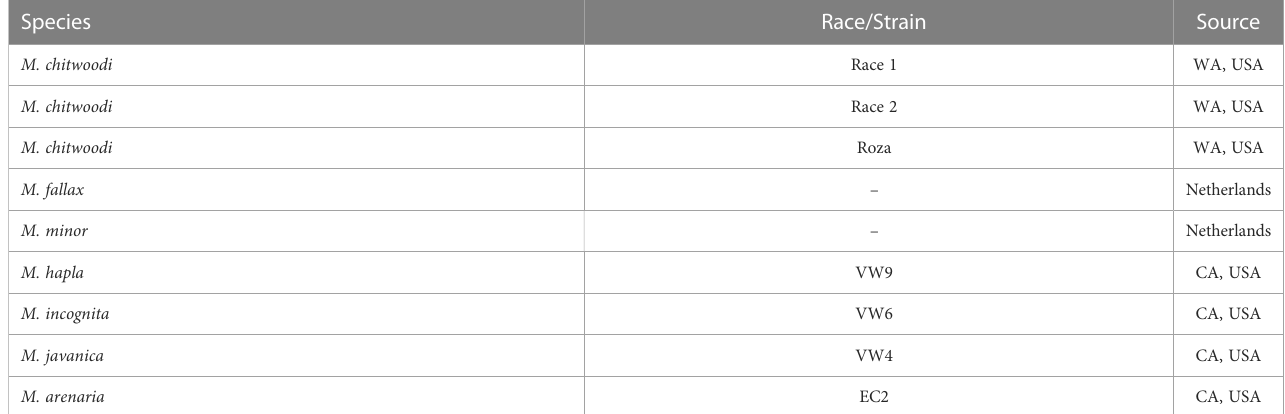
TABLE 3 Meloidogyne spp. used for testing molecular beacon RT-PCR speci fi